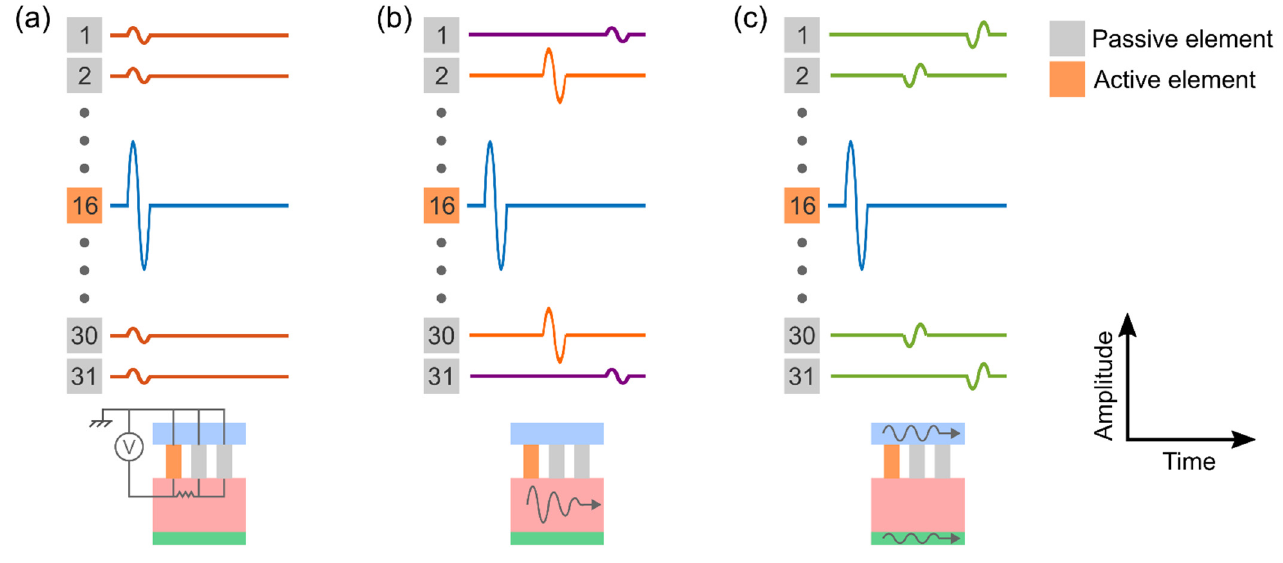
Figure A2. Assumptions for crosstalk simulations. ( a ) Electrical crosstalk. ( b ) Acoustical crosstalk